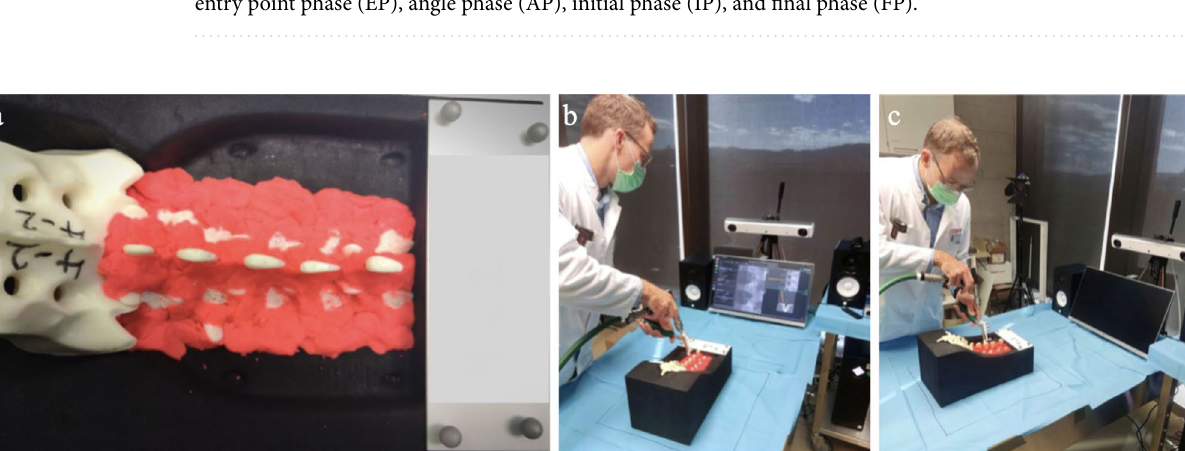
Table 1. Parameters for the FM synthesis mapping functions with the input data e = ( e x , e y , e φ , e δ ) ∈ [ 0, 1 ] for